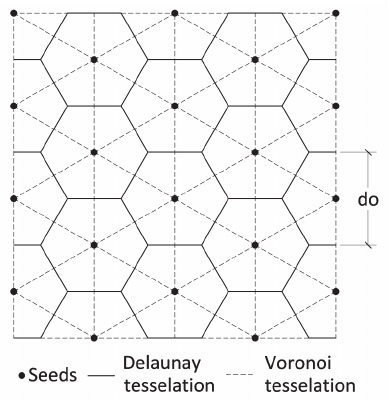
Figure 3: Voronoi construction applied to Delaunay disposition of